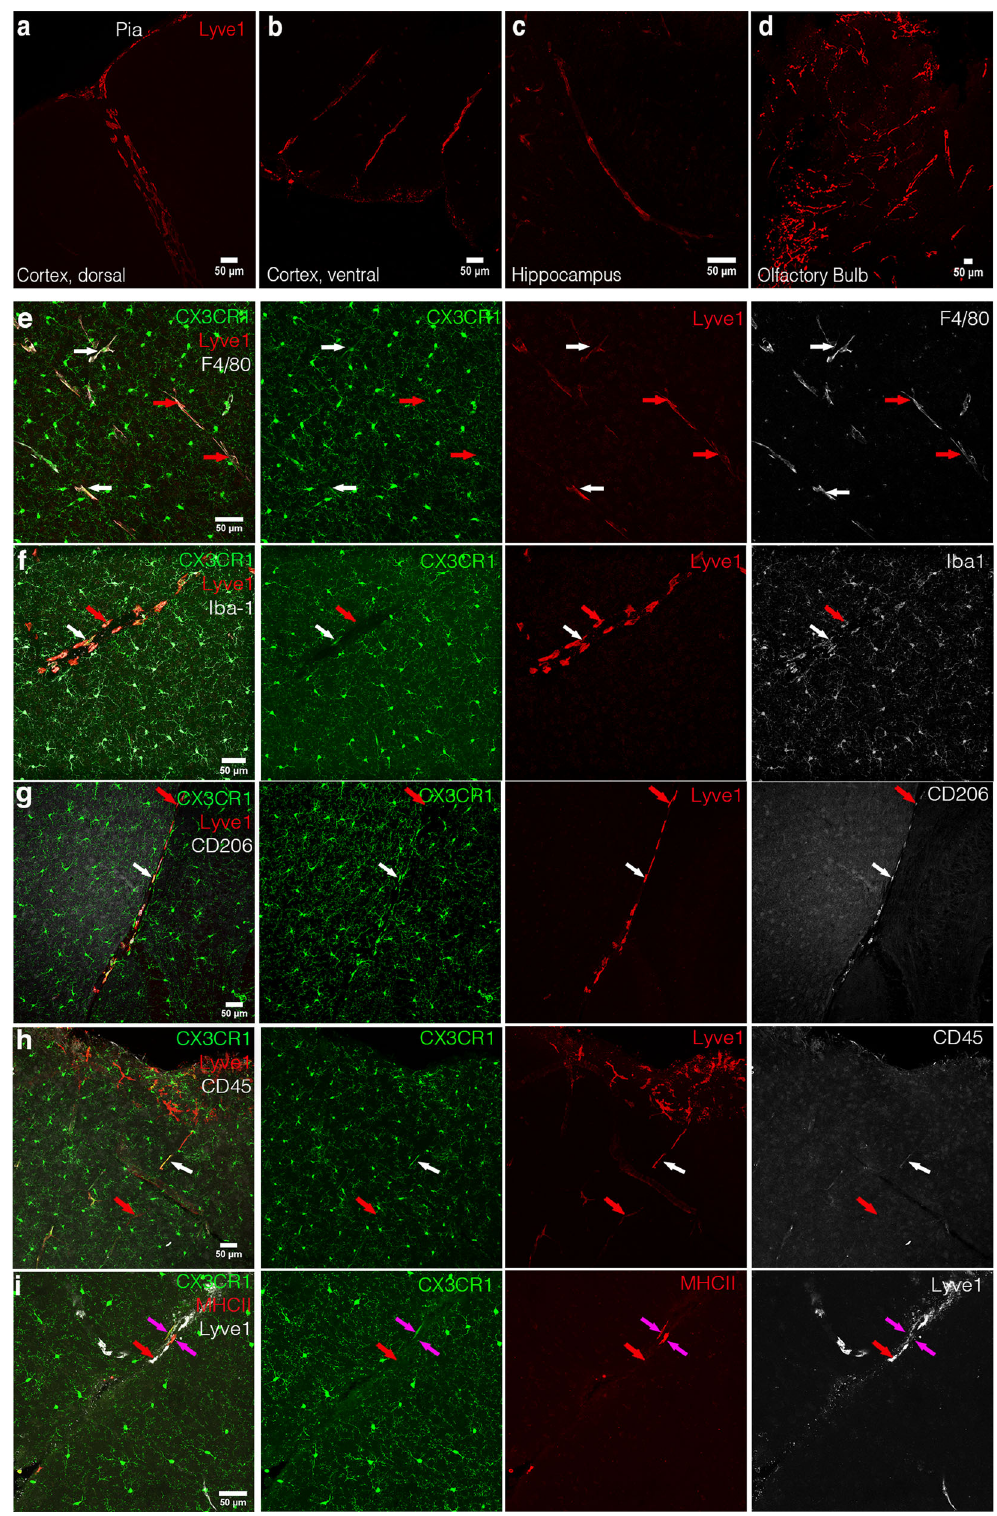
Fig. 1 | Identi fi cation of a Lyve1 + CX3CR1 – population in the mouse brain. Con- focal microscopy of brain sections stained with anti-Lyve1 showing the different Lyve1 + cellmorphologies in the cortexatthe dorsalside(17 µ m maximum intensity projection) ( a ), in the cortex at the ventral side (27 µ m maximum intensity pro- jection) ( b ), the Hippocampal fi ssure within the hippocampus (15 µ m maximum intensity projection) ( c ), and in the olfactory bulb (61 µ m maximum intensity pro- jection) ( d ) of an adult mouse brain. e – i Immuno fl uorescence microscopy on